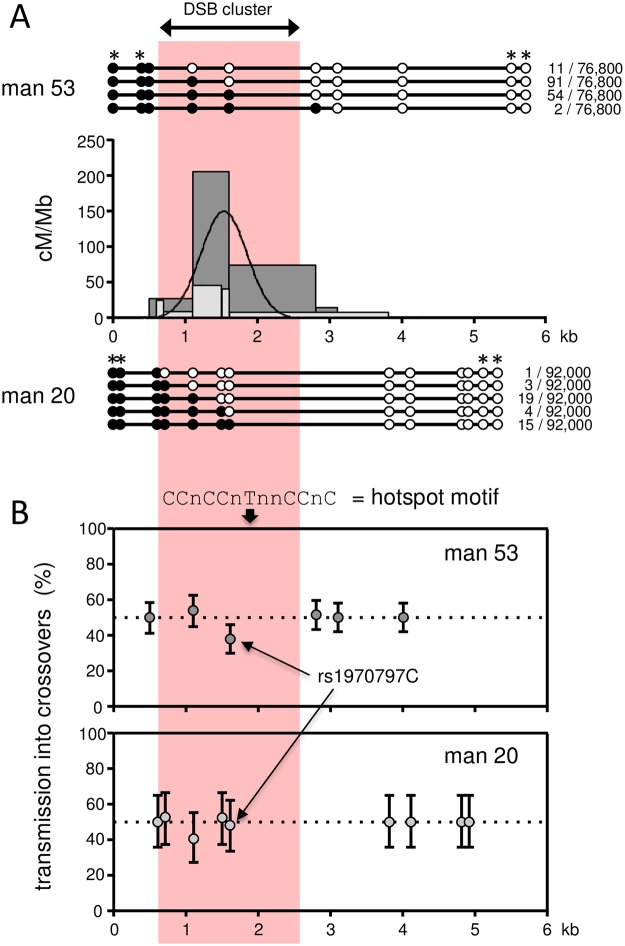
De novo sperm crossover activity in the distal region.(A) Sperm CO profiles for each of the two ePAR-carrying men analysed. A total of 158 recombinants were recovered from 76,800 sperm from man 53 using reciprocal crossover assays (i.e. Ab plus Ba COs, where AB and ab are the parental haplotypes) compared with 42 from a total of 92,000 sperm from man 20. Recombination activity expressed in cM/Mb along the assayed intervals is shown in the central graphs with the crossover activity of man 53 shown by the dark grey histogram and that of man 20 by the light grey histogram. The combined least-squares best-fit normal distribution for both men is shown by the black curve. The recovered CO structures together with their frequencies are shown above (man 53) and below (man 20) with heterozygous SNP locations represented by circles. SNPs marked with an asterisk were exploited for recombinant recovery (see Methods and S6 Table). The pink panel spans the interval in which male meiotic DSBs were previously mapped by DMC1-SSDS [19] and coincides with the peak CO activity determined from de novo sperm events in this study. (B) Transmission frequencies of SNP alleles into reciprocal COs with 95% credible intervals determined by Bayesian analysis. Transmission of the ‘strong’ allele (C or G) is shown for transition polymorphisms and transmission of the purine allele (A or G) is shown for the transversion polymorphisms. The upper panel shows the transmission data from man 53, the lower panel those for man 20. All markers with the exception of rs1970797 in man 53 were consistent with the expected 50:50 transmission of the two alleles into reciprocal events. This polymorphism lies 126 bp proximal to the predicted hotspot centre and 210 bp distal of the closest hotspot motif [73], as indicated at the top of the upper panel. CO asymmetry has previously been noted at hotspots that do not contain obvious matches to this motif, yet are nonetheless specifically activated by PRDM9 A [38,42]. Note that our failure to observe asymmetry for man 20 may simply be a consequence of the small number of COs detected for this donor.